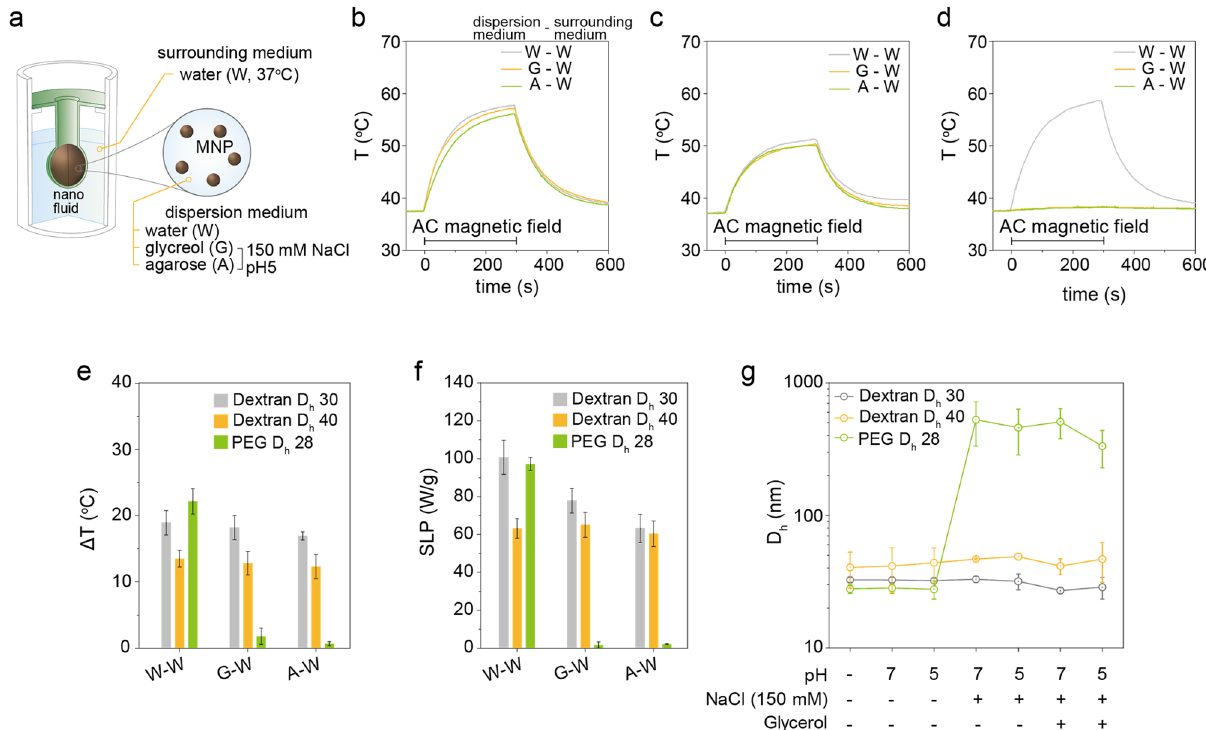
Figure 4. Effects of physiological conditions on the SLP and ΔT of MN during AC heat induction. ( a ) A schematic illustration of the experimental setup. Deionized water (W), glycerol (G), and agarose (A) with 150 mM NaCl and pH 5 were used as a dispersion medium for Mg doped γFe 2 O 3 MNs. The temperature of surrounding air and water media were RT (23 °C) and 37 °C, respectively. ( b – d ) The AC magnetic heat induction curves of dextran-110 k (Dextran D h 30, b ), dextran-10 k (Dextran D h 40, c ), and PEG- (PEG D h 28, d ) coated Mg doped γFe 2 O 3 MNs measured at the different dispersion media. ( e , f ) The measured ΔT ( e ) and SLP ( f ). ( g ) The hydrodynamic size change of dextran-110 k, dextran-10 k, and PEG-coated Mg doped γFe 2 O 3 MNs in dispersion media with various biological